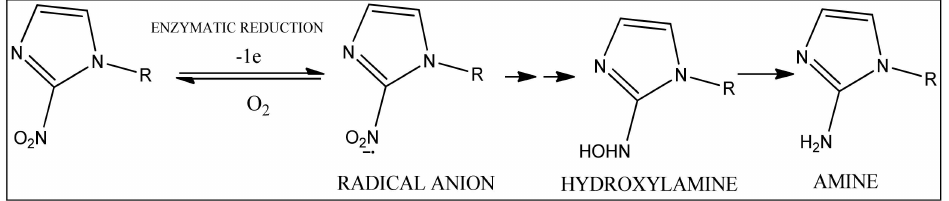
Figure 1. Mechanism of “in vivo” reduction of